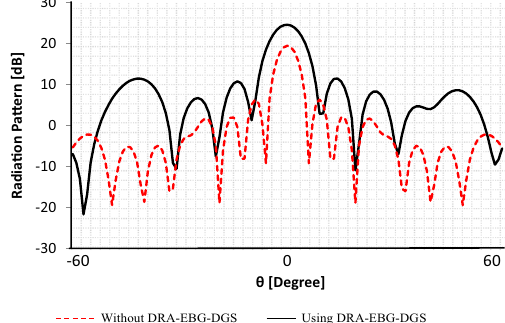
Fig. 8 Simulation result of 2D radiation